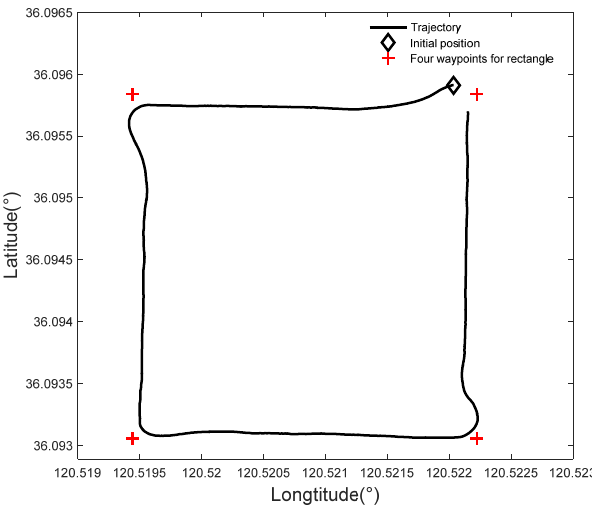
Figure 15. Rectangular trajectory tracking of the USV in the sea experiment.